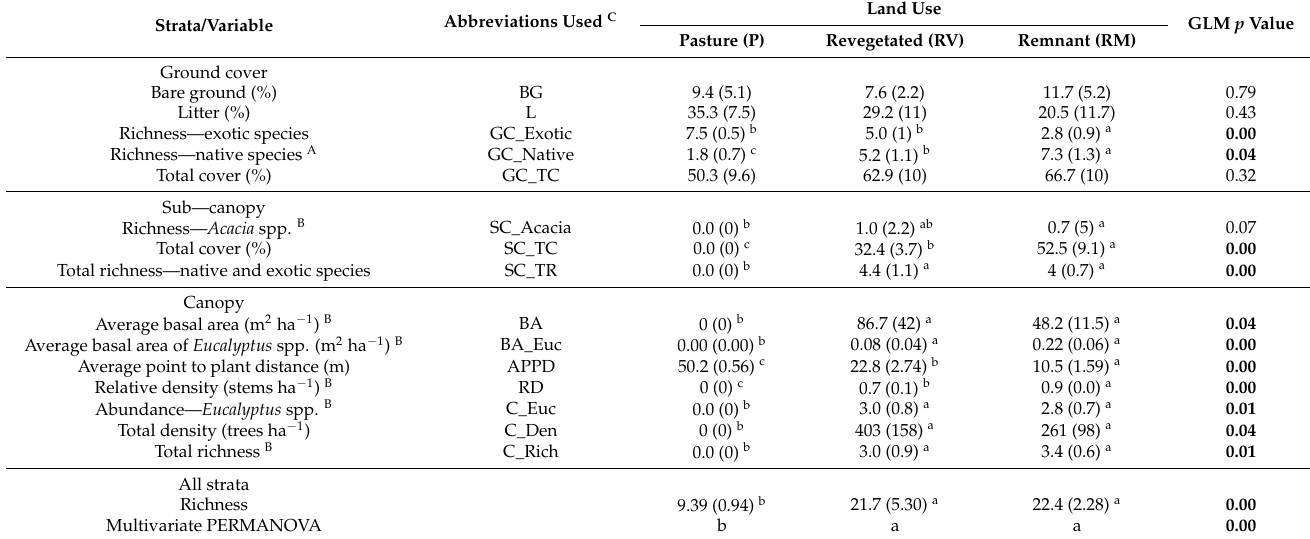
Table 2. Vegetation properties of the three land-use types (P, pasture; RV, revegetated; RM, remnant) across six sites. Values represent means ( ± SE) with p values from general linear models (GLM) testing for the effect of land use (L). Significant differences (Tukey HSD test) between land uses are indicated by superscript letters and are bold for p values < 0.05. Study site was included as a random factor. PERMANOVA tested for differences in the Euclidean distance matrix among land-uses across all